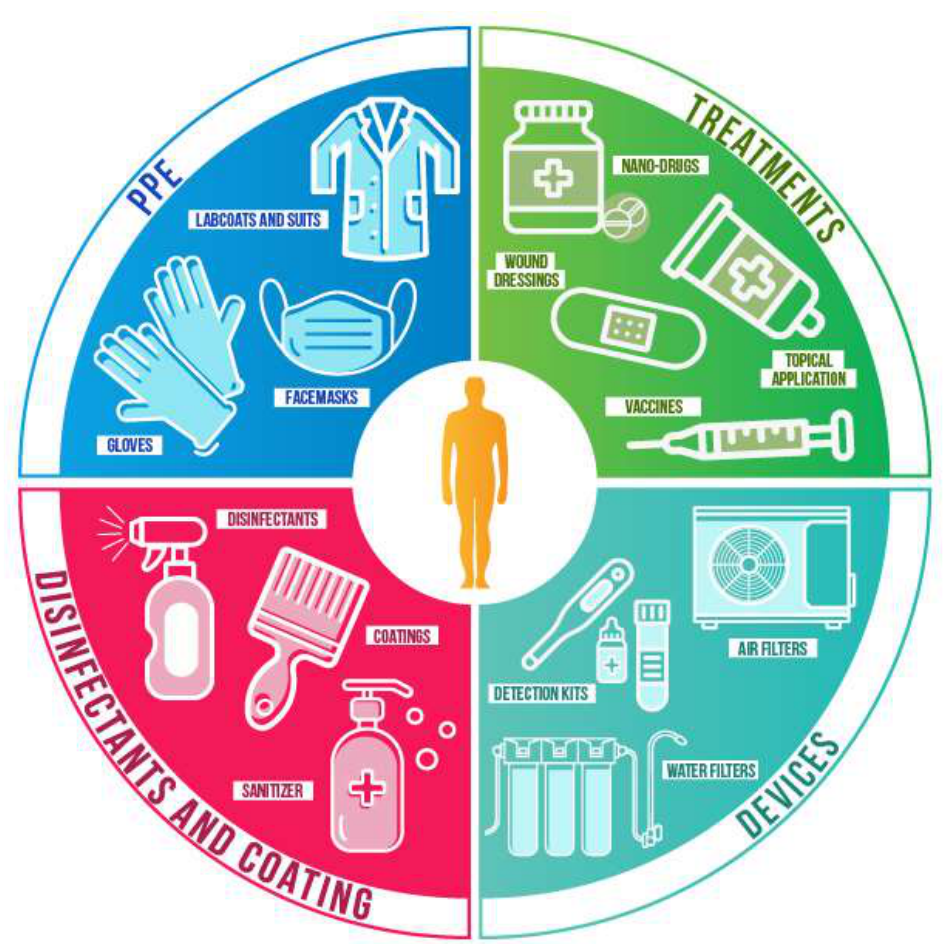
Figure 3. Representative uses of nanotechnology to combat viruses and other pathogens.